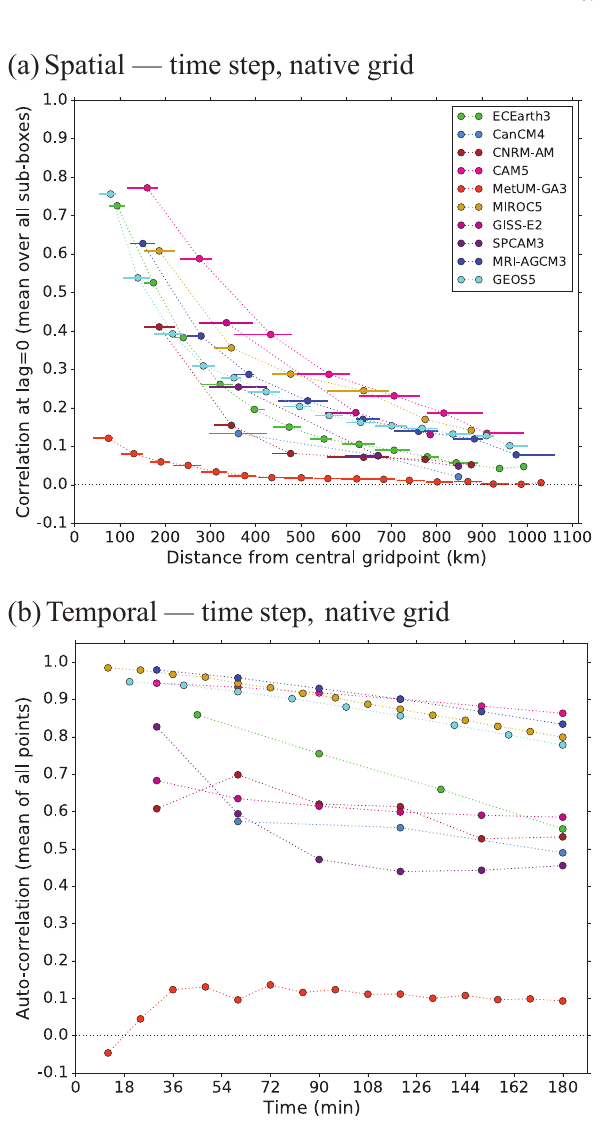
Figure 6. For the GASS/YoTC models, using time step precipita- tion data on the native model grid: (a) a measure of the spatial scale of precipitation features, computed by dividing the analysis domain into 1500km × 1500km regions and calculating the instan- taneous linear correlation between the central gridpoint and grid- points within each distance bin (which are (cid:49)x wide, starting from 0.5 (cid:49)x ) away from the central gridpoint, then averaging the correla- tions over all regions in the domain; (b) a measure of the temporal scale of precipitation features, computed as the auto-correlation of precipitation, averaged over all points in the domain. The horizon- tal lines in (a) show the range of distances spanned by each distance bin; the filled circle is placed at the median distance. For clarity, we omit the correlations for zero distance and zero lag, which are 1.0 by